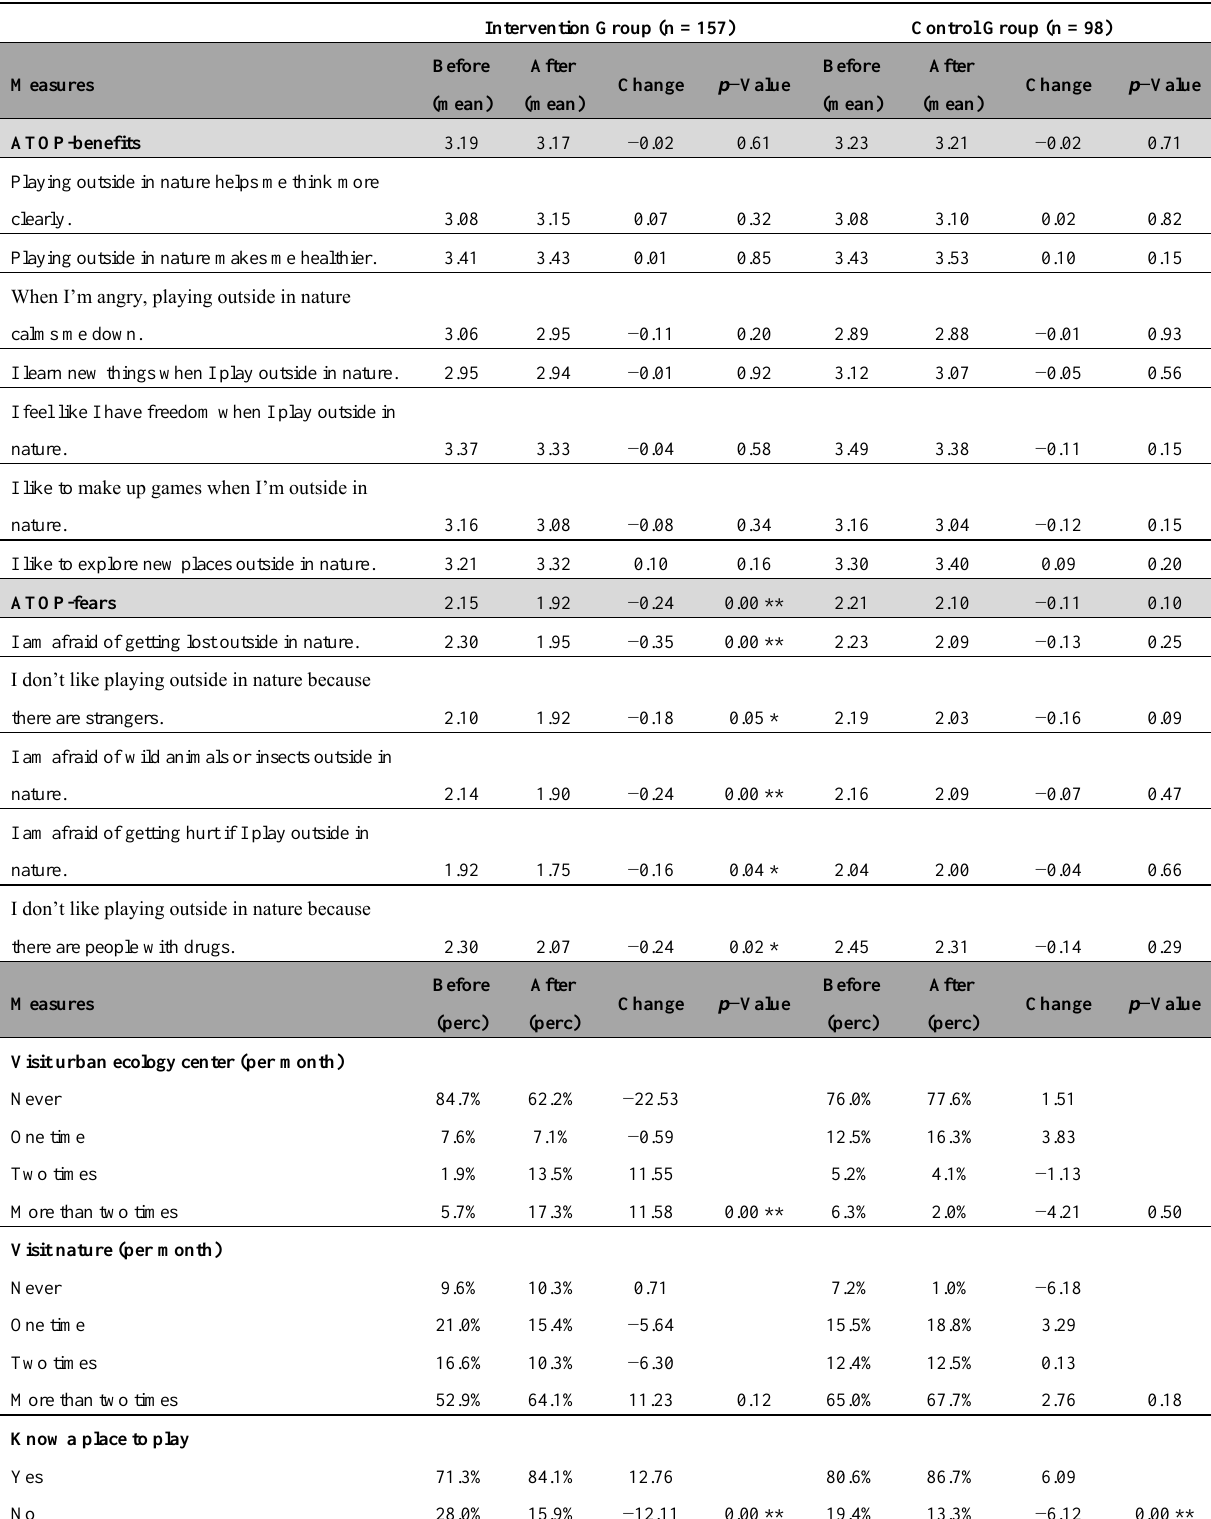
Table 2. Pre, post and change in scores for intervention and control group.